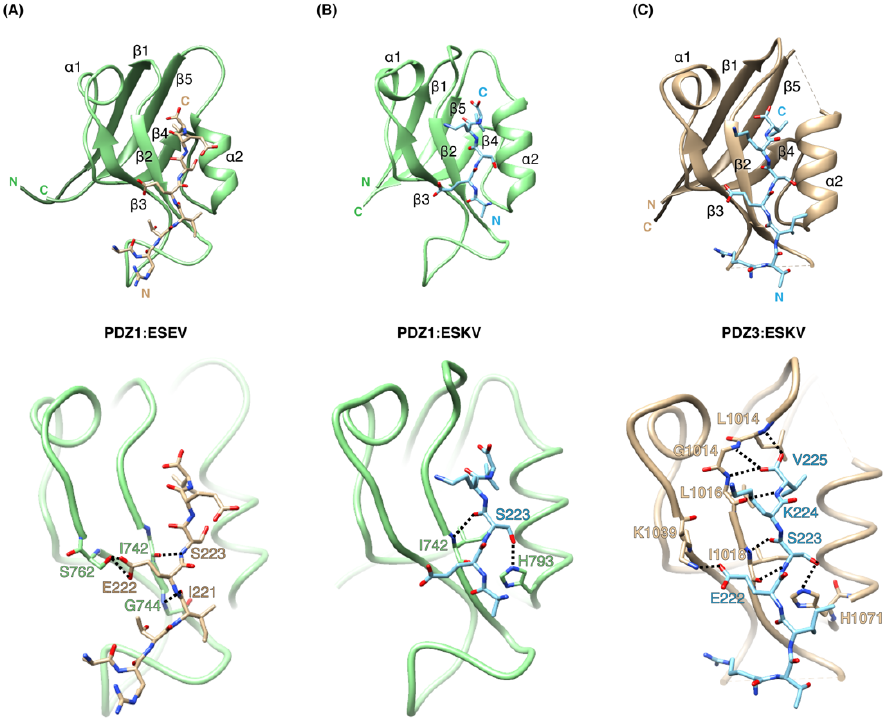
Figure 3. The crystal structures of SCRIB PDZ domains bound to NS1 PBM motif peptides. ( A ) SCRIB PDZ1:ESEV complex with PDZ1 domain (green) shown as a cartoon, and NS1 ESEV peptide (gold) in the top panel. Detailed interactions are shown in the bottom panel. ( B ) SCRIB PDZ1:ESKV complex, with PDZ1 domain (green) shown as a cartoon, and NS1 ESKV peptide (blue) as sticks in the top panel. Detailed interactions are shown in the bottom panel. ( C ) SCRIB PDZ3:ESKV complex with SCRIB PDZ3 domain (gold) shown as a cartoon, and NS1 ESKV peptide (blue) as sticks in the top panel. Detailed interactions are shown in the bottom panel. Interactions are denoted as black dotted lines.